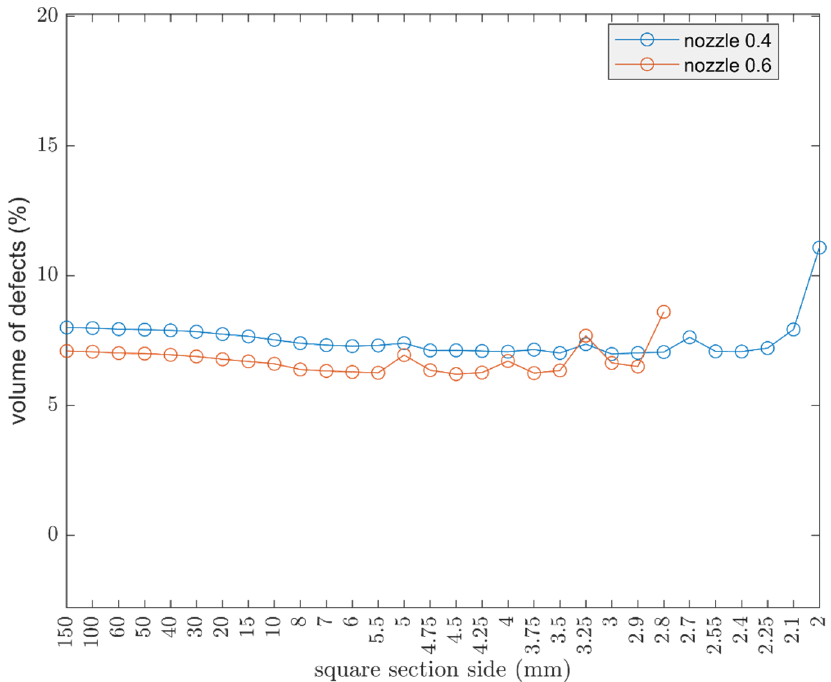
Figure 13. Comparison on the influences of the geometry considering the 0.4 mm and 0.6 mm nozzle; in the case of a 0.4 mm nozzle, the layer height is 0.15 mm, width 0.4 mm; in the case of a 0.6 mm nozzle, the layer height is 0.2 mm and width 0.6 mm.